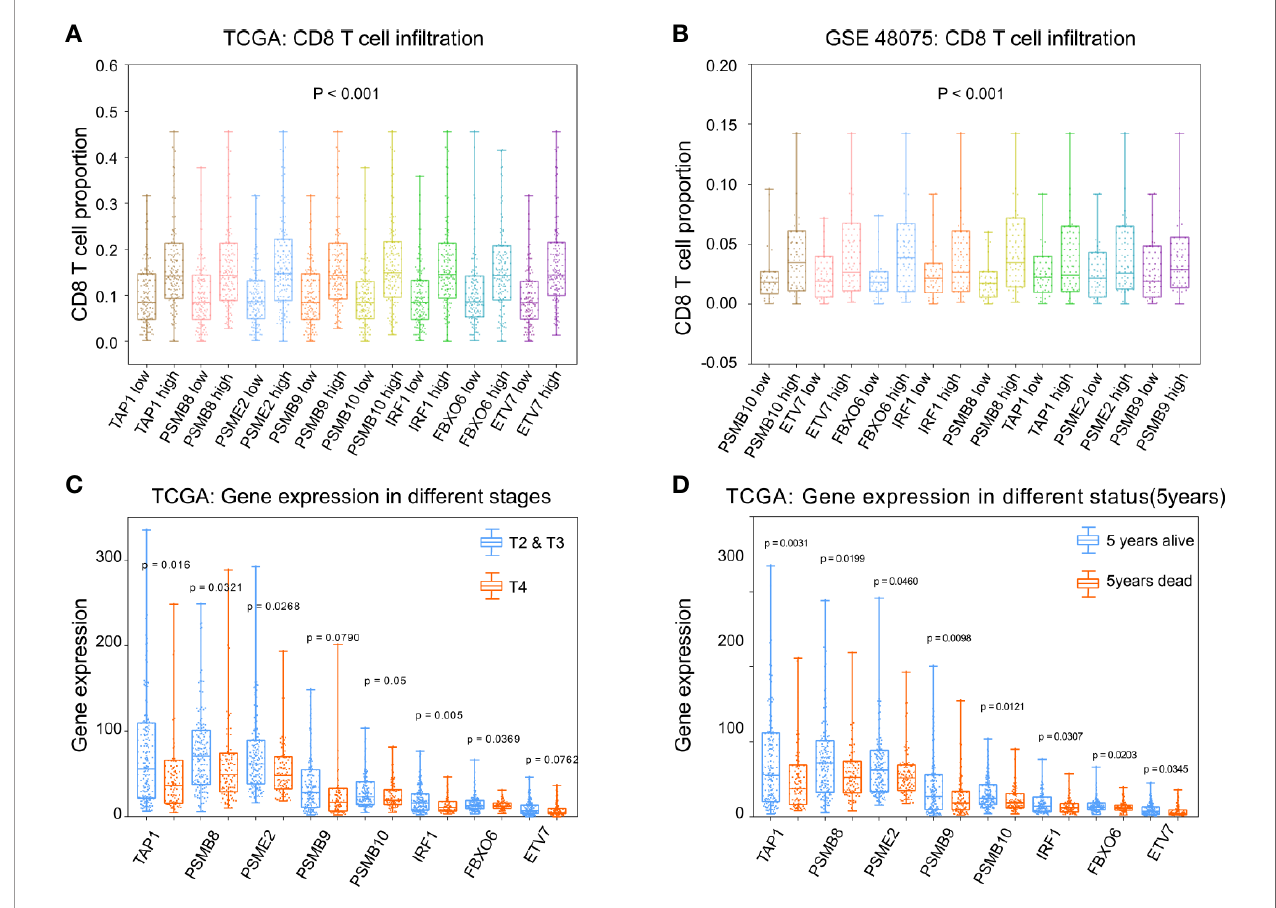
FIGURE 6 | Phenotype analysis of PSMB8 , PSMB9 , PSMB10 , PSME2 , TAP1 , IRF1 , FBOX6, and ETV7 with CD8 + T cell in fi ltration proportions. (A) There was higher in fi ltration proportion in high expression groups ( p < 0.05) of PSMB8 , PSMB9 , PSMB10 , PSME2 , TAP1 , IRF1 , FBOX6 , and ETV7, suggesting that these genes promote CD8 + T cell in fi ltration in TCGA. (B) Higher in fi ltration proportions in high expression groups of PSMB8 , PSMB9 , PSMB10 , PSME2 , TAP1 , IRF1 , FBOX6 , and ETV7 , suggesting that these genes promote CD8 + T cell in fi ltration in GSE48075. (C) Expression level in stages 2/3 of these genes were higher than in stage 4. (D) Expression levels in the 5-year survival group of these genes were higher than those of the 5-year death group.